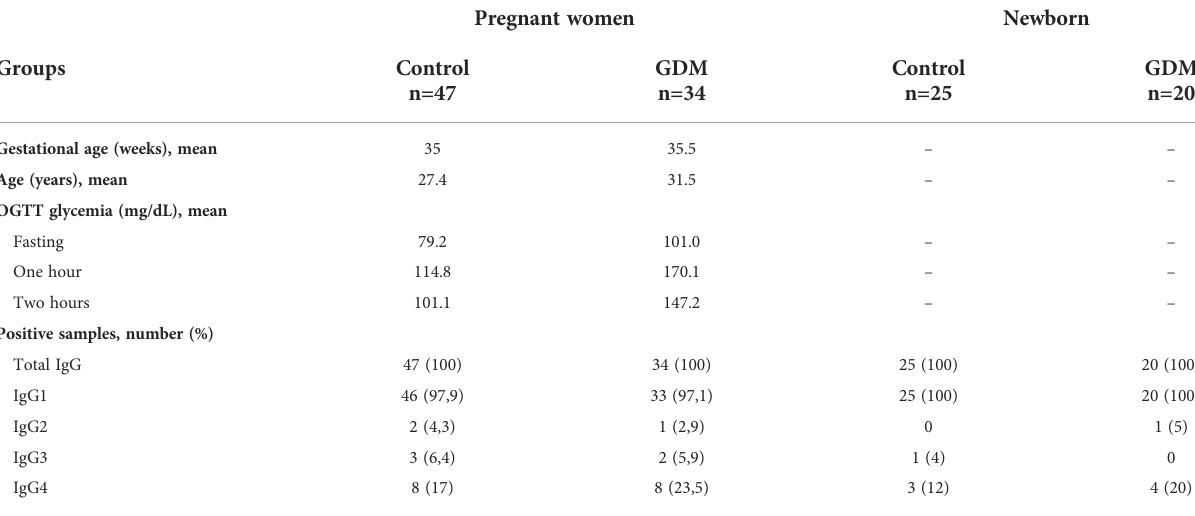
TABLE 1 Sample characterization, number and percentage of pregnant women with and without Gestational Diabetes Mellitus (GDM) and their newborns, in relation to seropositivity for anti- T. gondii